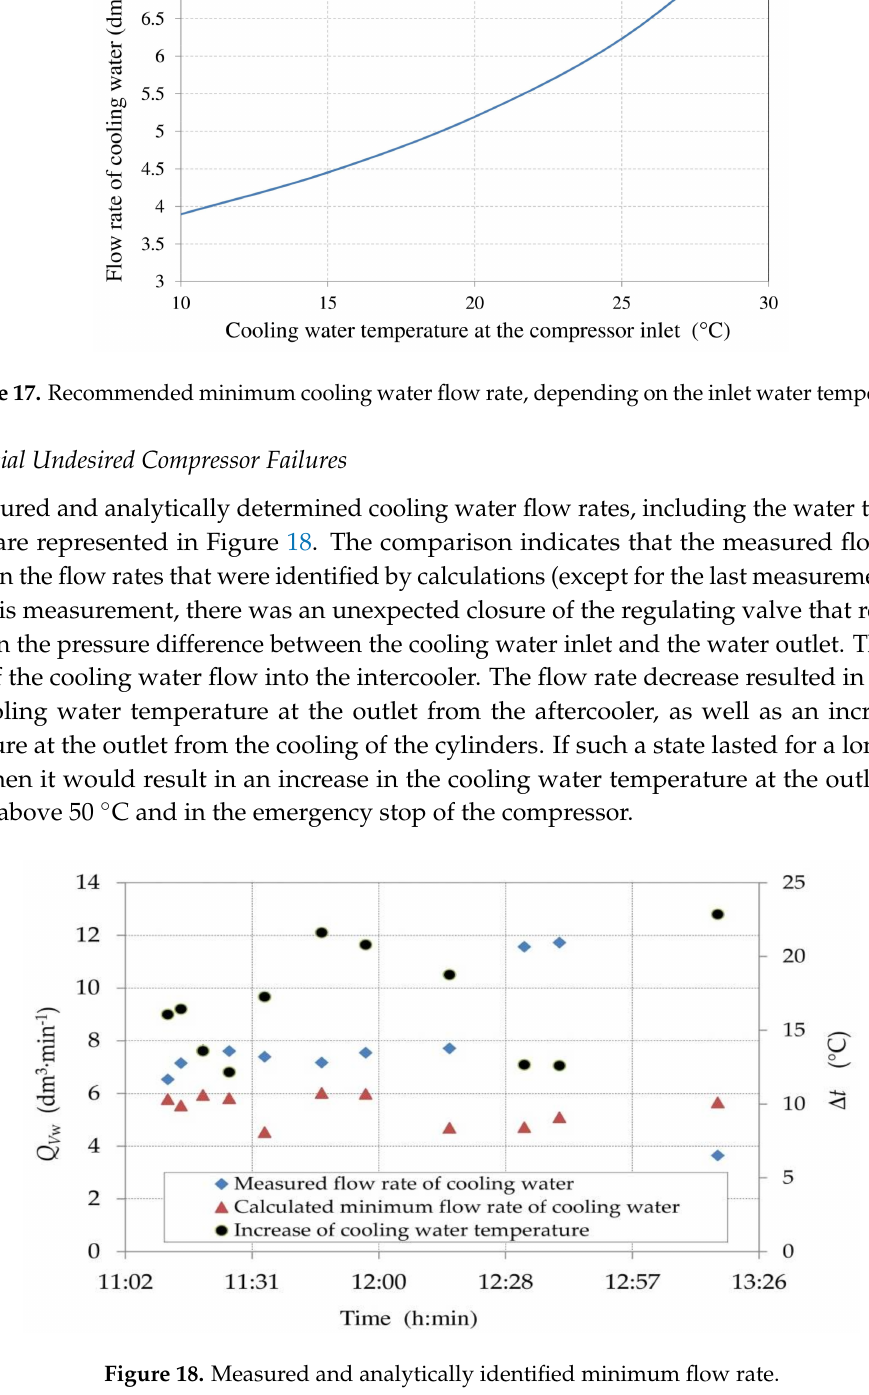
Figure 18. Measured and analytically identified minimum flow